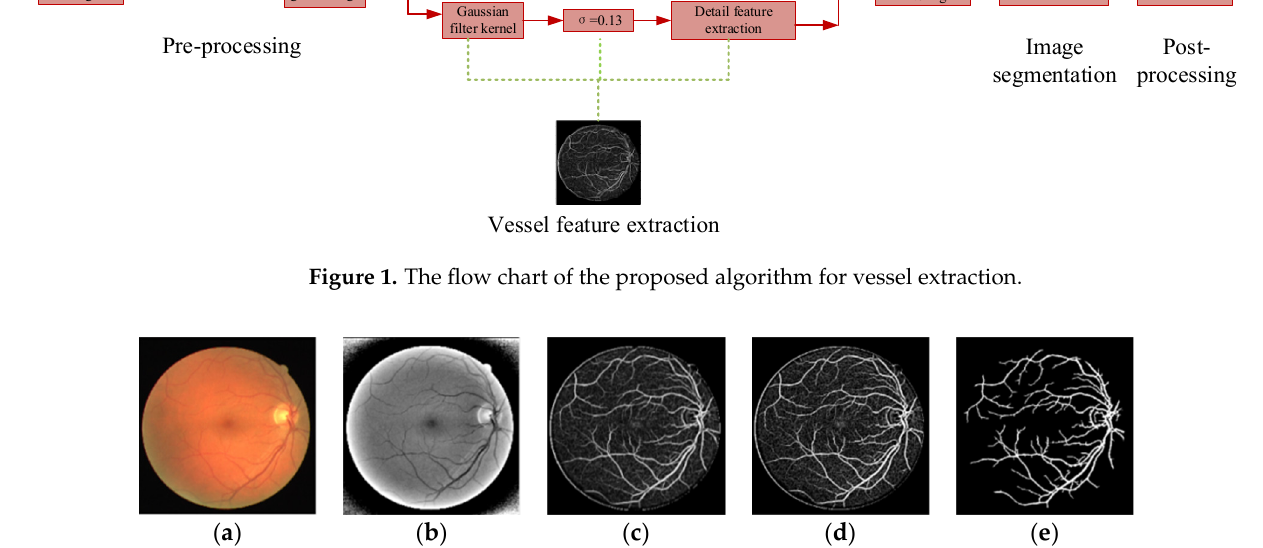
Figure 2. Multiscale joint Optimization strategy. ( a ) Original color image; ( b ) Pre-processing result; ( c ) Multi-scale filtering; ( d ) OTSU image segmentation based on PSO (OTSU-PSO); ( e ) Post-pro- cessing.